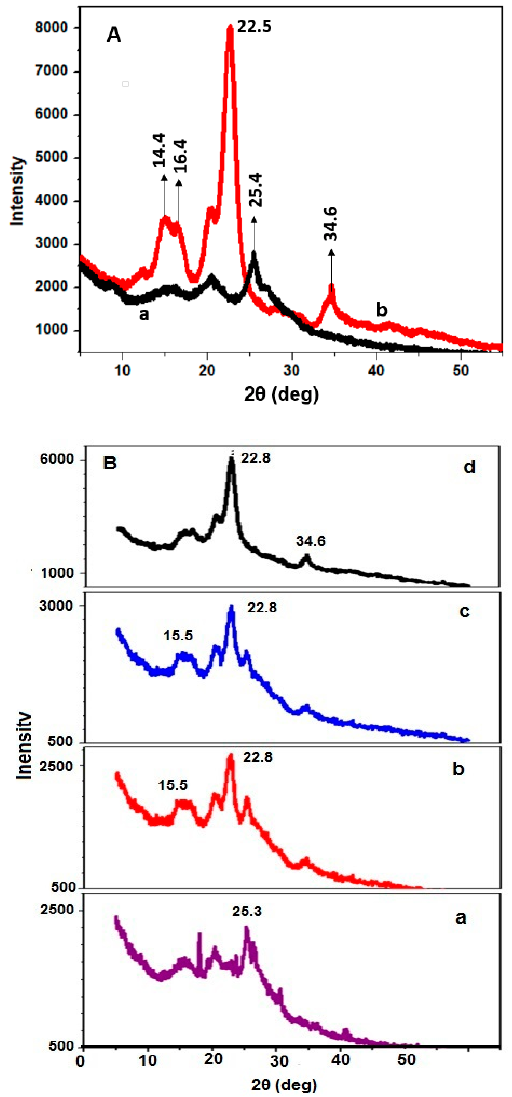
Figure 6. ( A ) X-ray diffractrograms of (a) pure PAni, and (b) MCC; ( B ) PAni/MCC prepared from different mass ratio of Ani/MCC (a) 0.93/0.07; (b) 0.74/0.26; (c) 0.56/0.44; (d) 0.37/0.63. The XRD diffractogram of MCC (Figure 6A(b)) showed the highest intensity at 2 θ = 22.5°, and two small peaks at 2 θ = 16.4° and 14.6° correspond to the Miller indices of (200), (110) and (1–10), respectively [35]. Pure MCC also displayed a small peak at 2 θ = 34.6°, all confirming the typical pattern for cellulose I.